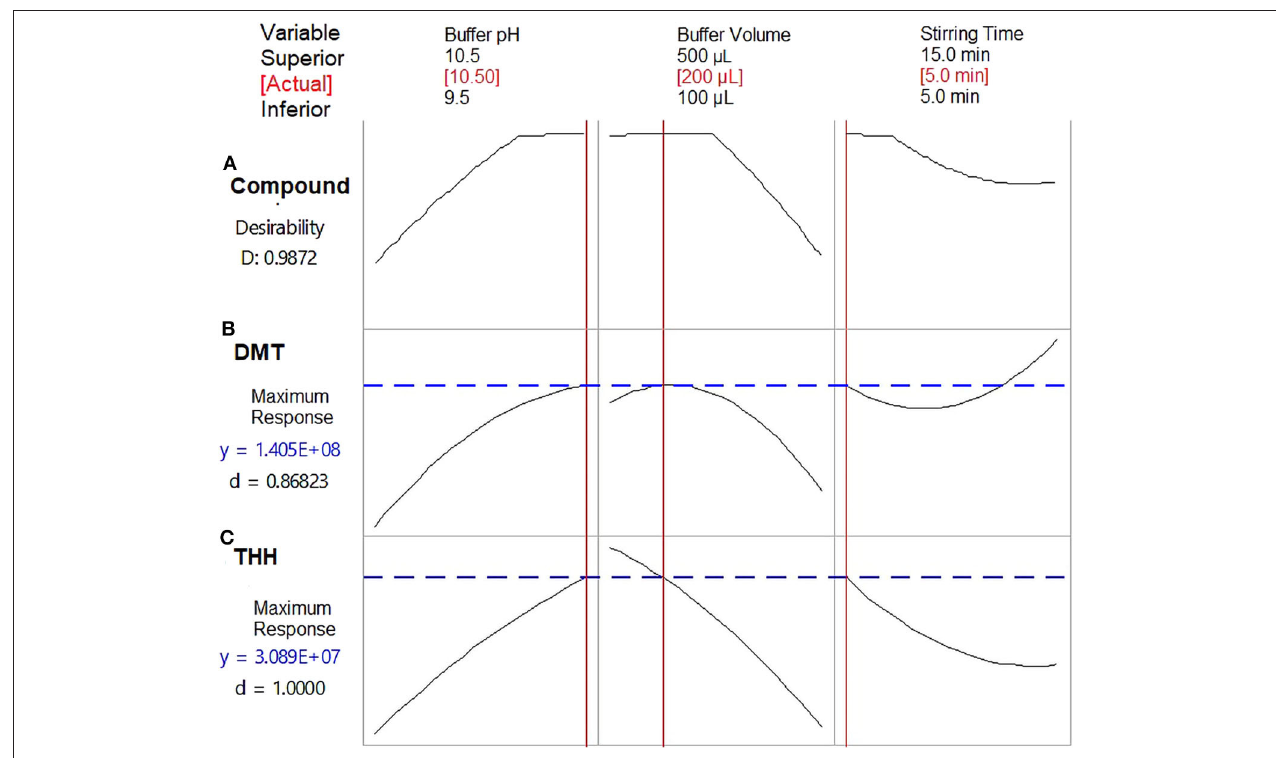
FIGURE 5 | Optimization plots presenting the best combined response for dimethyltryptamine (DMT) and tetrahydroharmine (THH). (A) Combined variables for maximum response of both analytes; (B) Combined variables for maximum DMT response; (C) Combined variables for maximum THH response. D, desirability function. Results from Box–Behnken design.